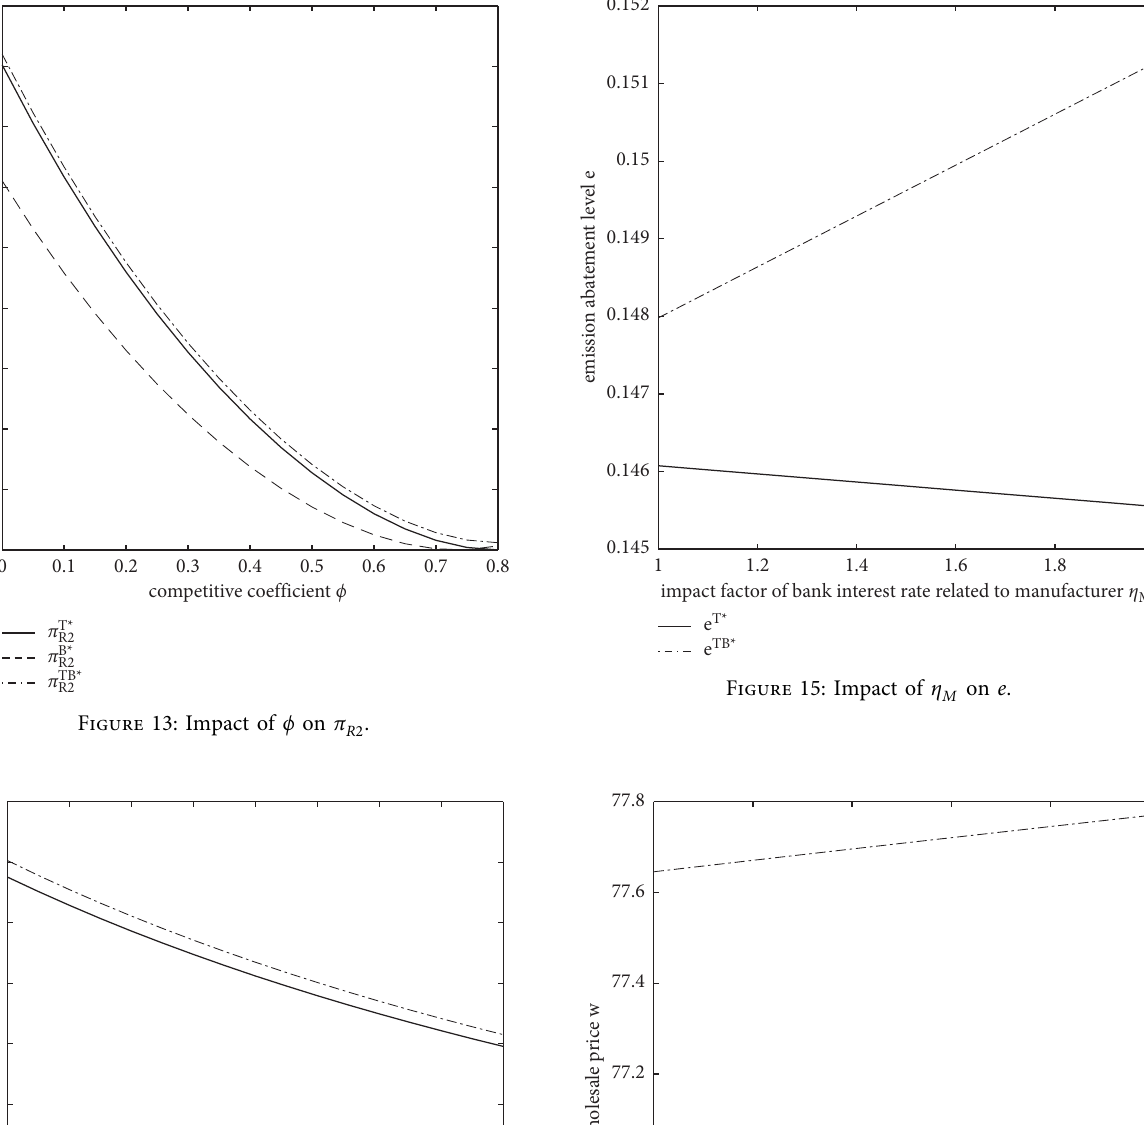
Figure 16: Impact of η